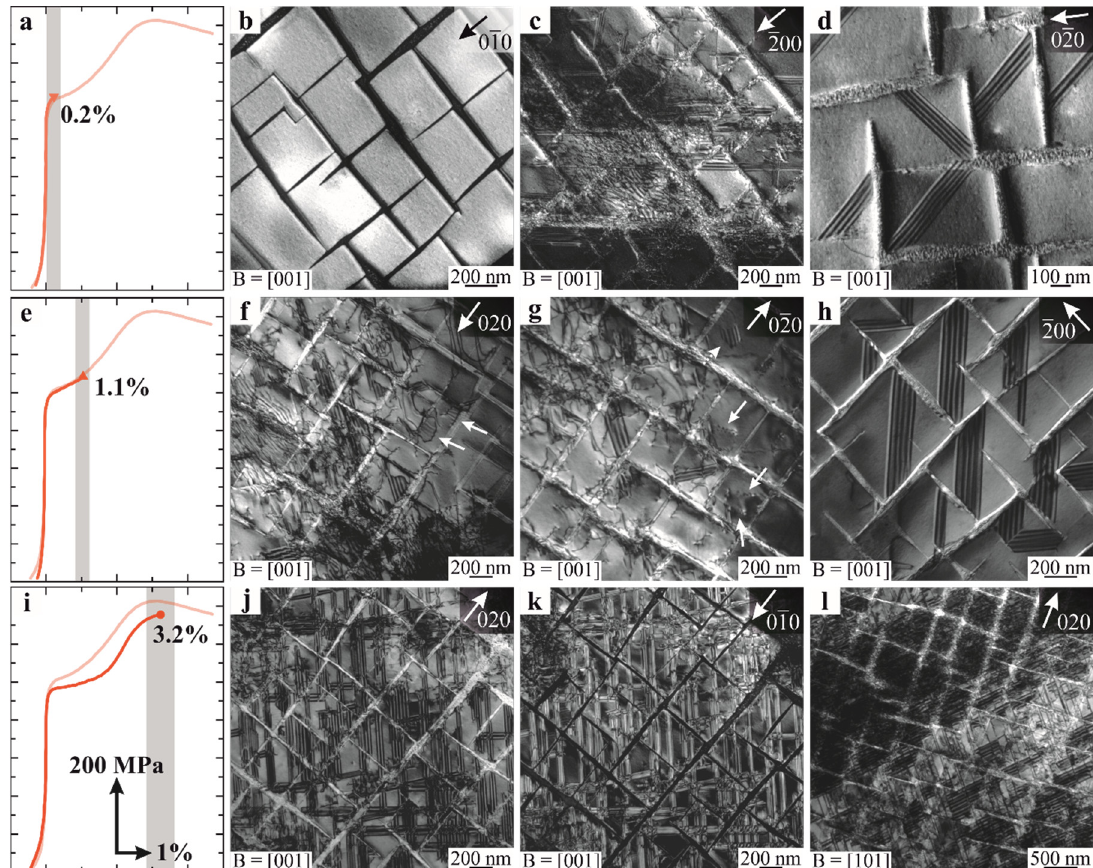
Figure 2. Defect structures in VF60 after compression tests at 950 °C and a strain ‐ rate of 1 ⋅ 10 − 4 s − 1 interrupted at ( a – d ) 0.2% plastic strain, ( e – h ) 1.1% plastic strain and ( i – l ) 3.2% plastic strain. The interrupted stress ‐ strain curves are shown in ( a , e , i ). All TEM micrographs were taken in two ‐ beam conditions close to the [001] zone axis except (l), which was taken close to the [101] zone axis, and with ( f , j , l ) g = 020 (BF), ( d , g ) g = 0–20 (CDF), ( c , h ) g = − 200 (CDF), and ( b , k ) g = 0–10 (CDF).